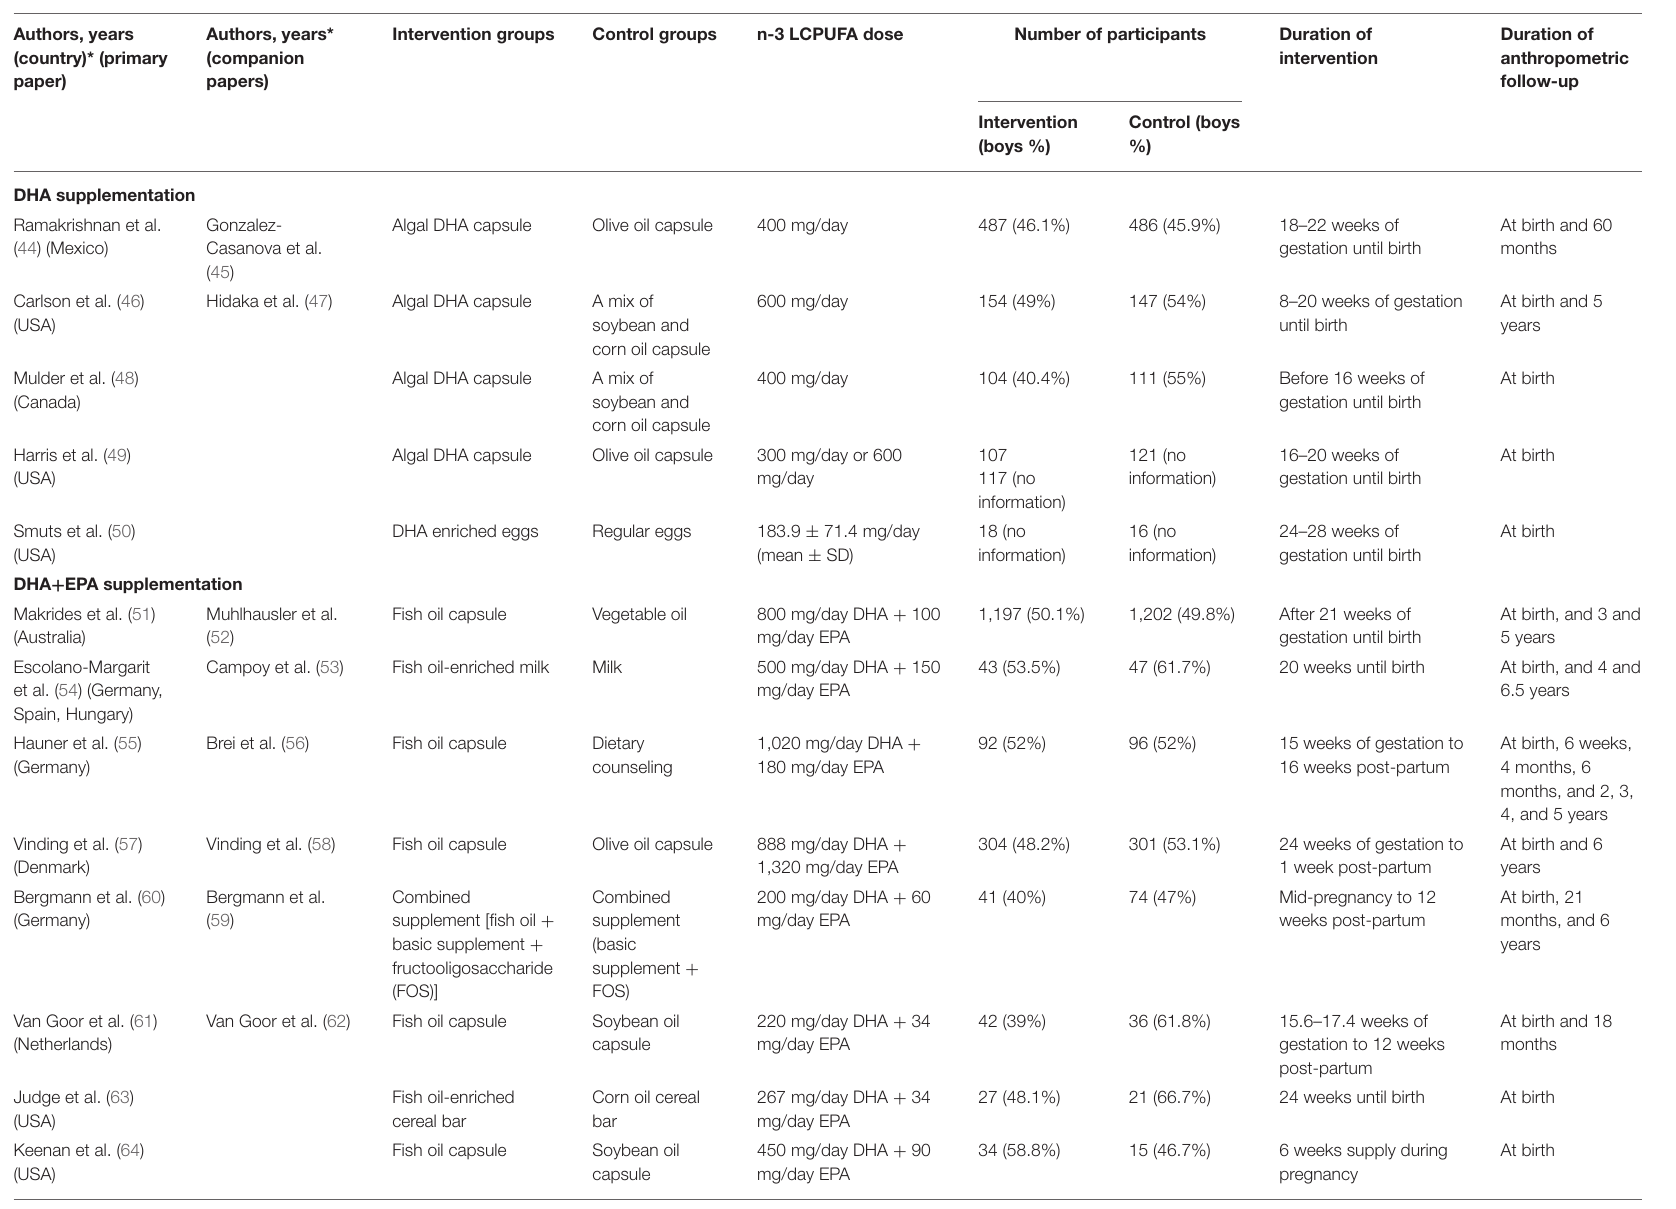
TABLE 1 | Summary of DHA supplementation